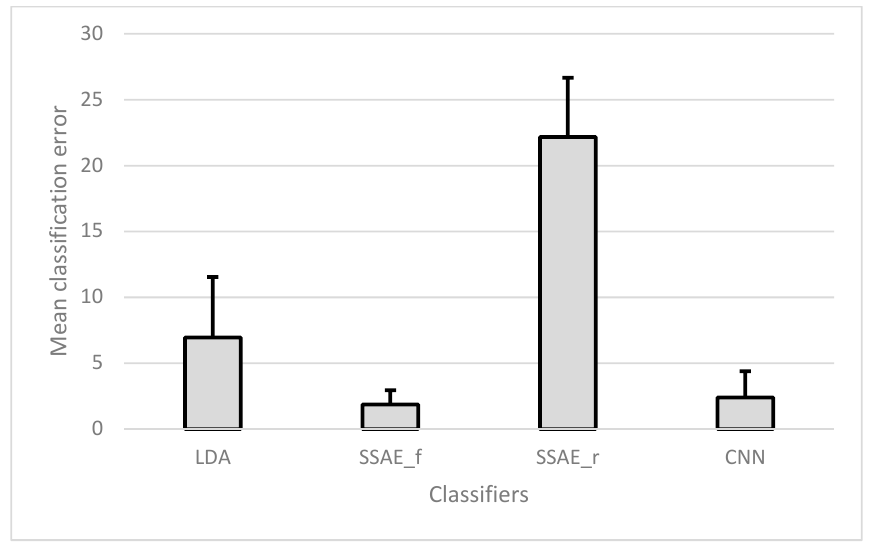
Figure 5. Mean (and SD) classification error of all classifiers for within-session analysis with 10-fold cross-validation averaged over the 15 days. LDA: linear discriminant analysis; SSAE-f: stacked sparse autoencoders with features; and SSAE-r: stacked sparse autoencoders with raw samples.